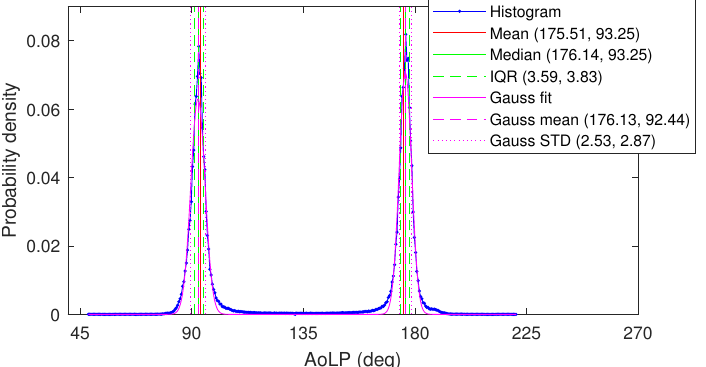
Figure 17. Histogram for the large ROI of Figure 16 in a similar format to the case of Figure 10. An interim conclusion at this point is that the approach has the capability to estimate average fibre angles to a precision of at least 1° but that pixel-by-pixel estimates can